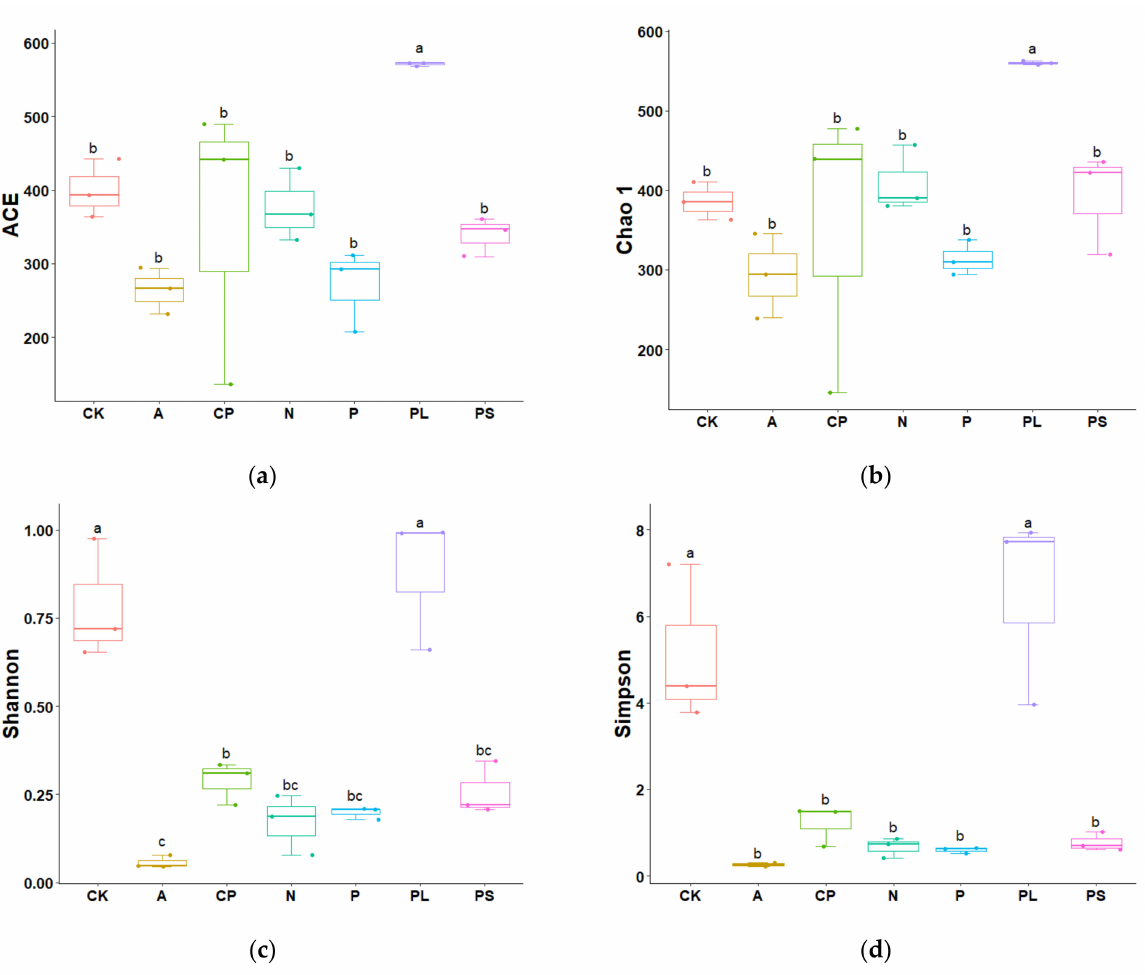
Figure 2. Box plots of ( a ) ACE, ( b ) Chao 1, ( c ) Shannon, and ( d ) Simpson’s values of gut microbiota of Grapholita molesta feeding on different host plants. Different capital letters on the abscissa represent different diets: CK, artificial diet; A, apple-feeding; CP, crisp pear-feeding; N, nectarine-feeding; P, peach-feeding; PL, plum-feeding; PS, peach shoot-feeding. Different lowercase letters on boxes indicate significant differences (one-way ANOVA, Tukey post-hoc test, p < 0.05) in the mean